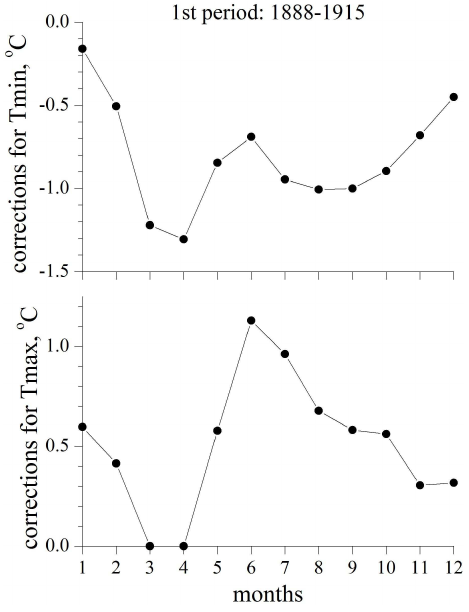
Figure 6. Porto: corrections (in ◦ C) for T min (top panel) and T max (bottom panel) series for the period before the break,